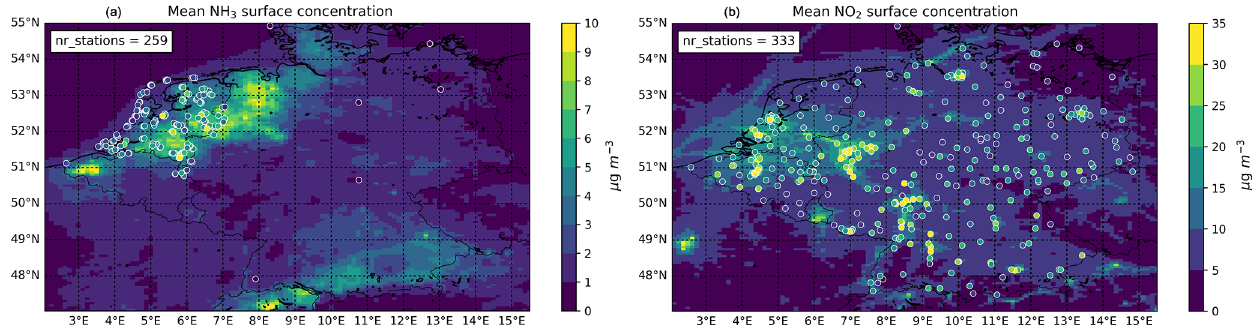
Figure 14. The yearly mean NH 3 (a) and NO 2 (b) surface concentrations in µgm − 3 in 2014 and the corresponding mean surface concentra- tions measured at the in situ